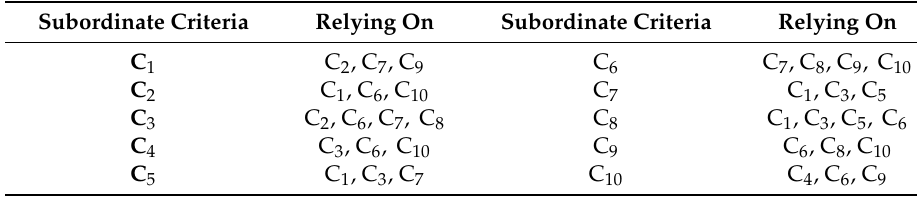
Table 4. Mutuality through